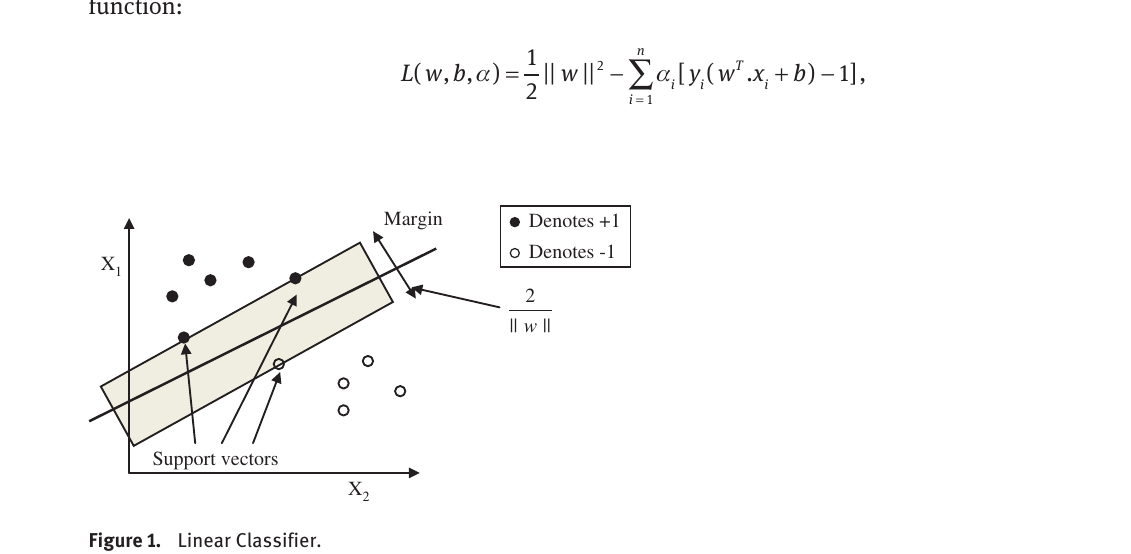
Figure 1. Linear